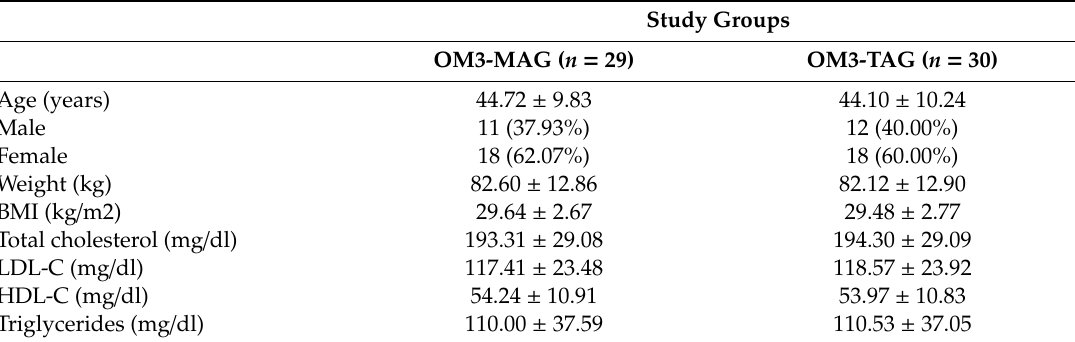
Table 5. Clinical Trial B. Study group